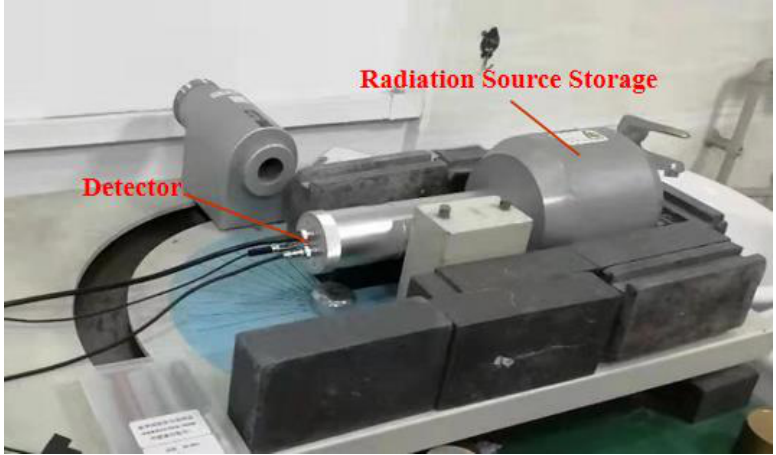
Figure 10. A picture showing the gamma-ray absorption experiment Figure 10